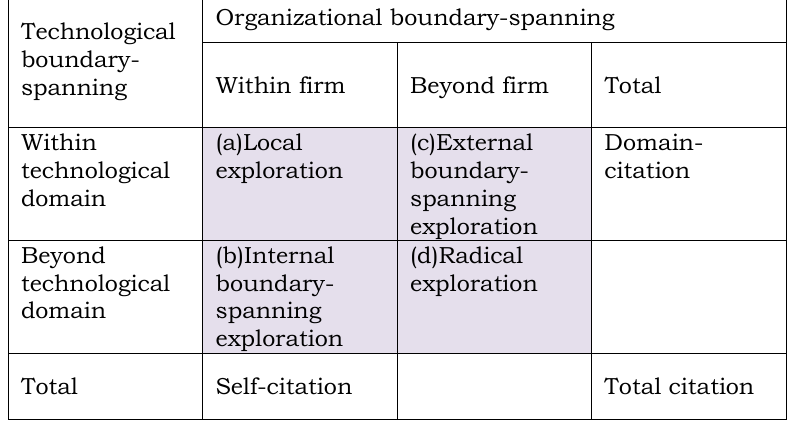
Table 1. Four types of